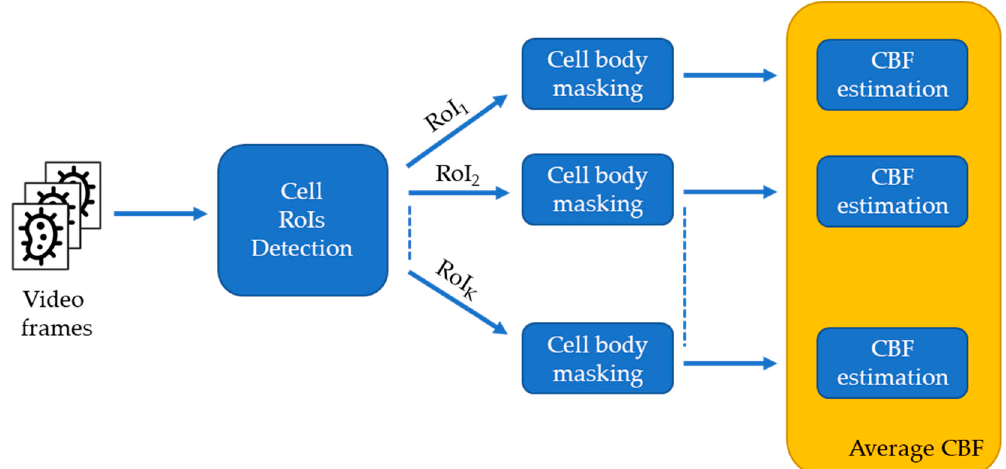
Figure 2. Block diagram of the logical pipeline of the developed system. Video frames are the input, then cell RoIs. Detection takes place, followed by cell body masking. The final step is the CBF estimation. The average CBF is computed if more than one cell is detected in the microscopic field.